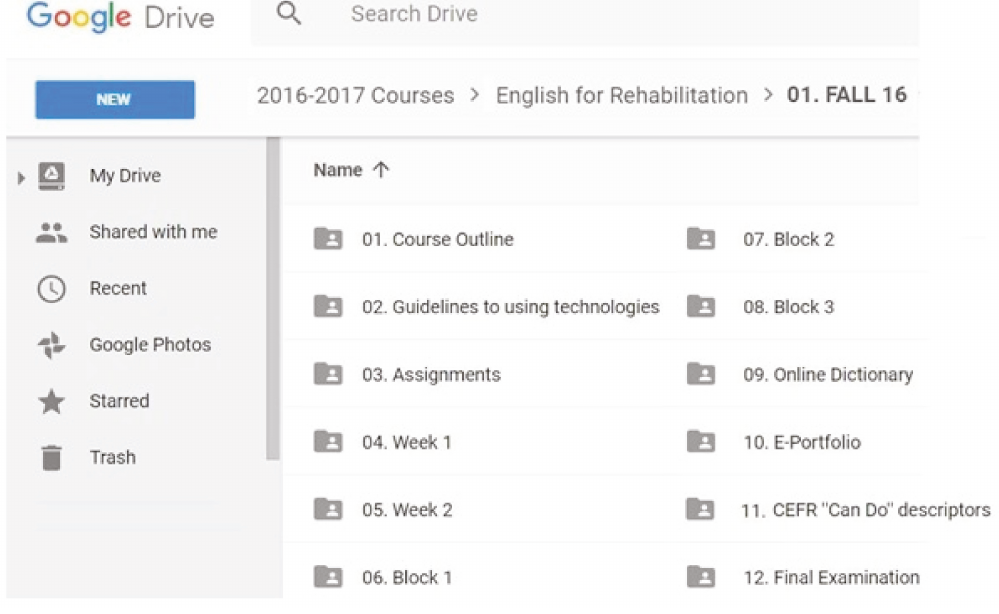
Figure 2. Google Drive (Google, Inc., Mountain View, CA, USA) course resources storage. Used with